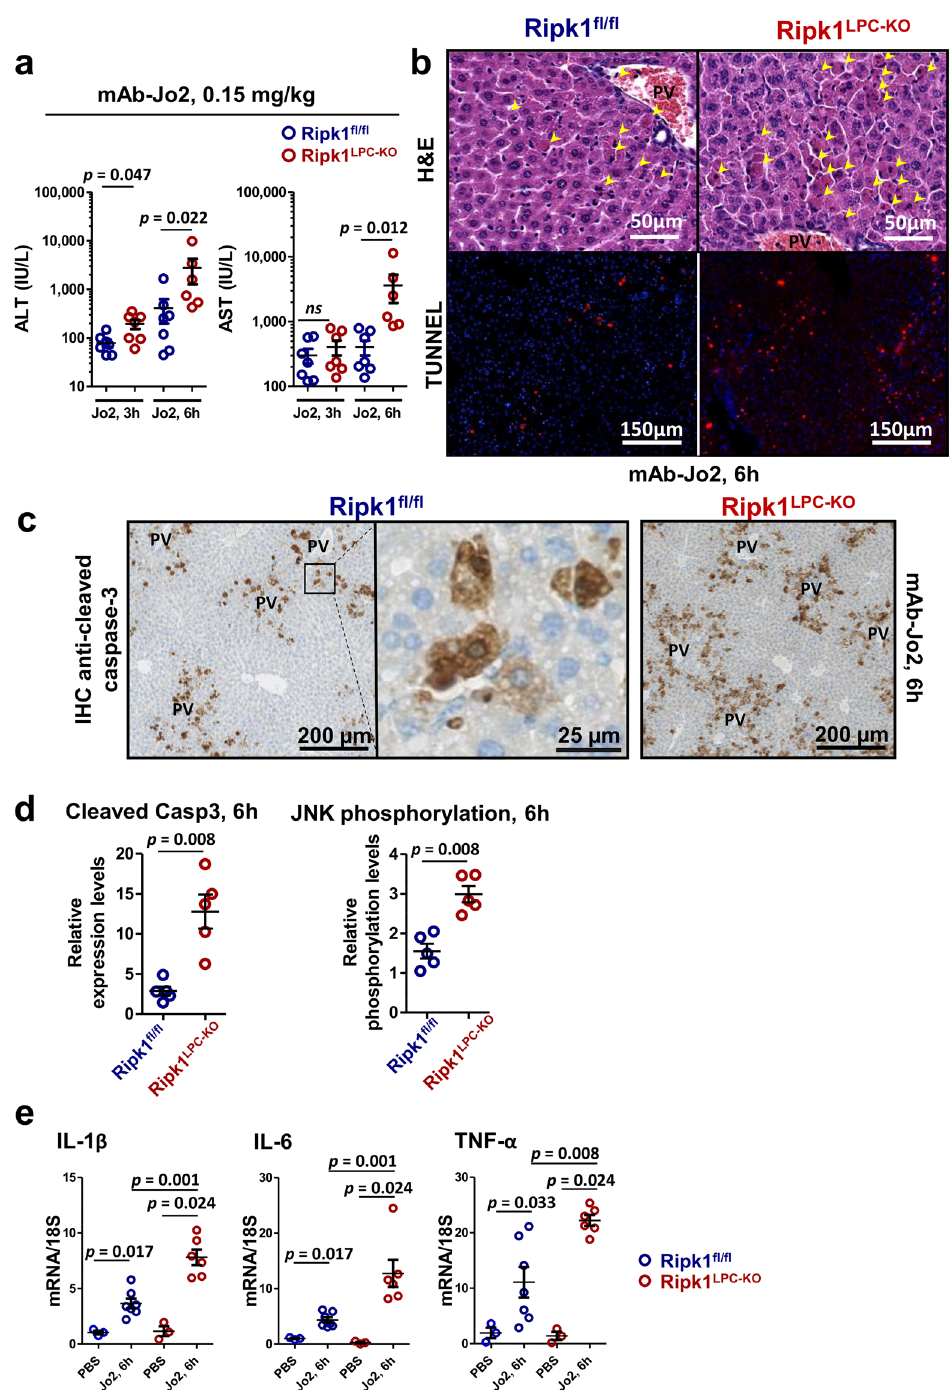
Figure 2. RIPK1 deficiency sensitizes mice to Fas-mediated liver injuries. ( a ) Levels of serum ALT and AST, 3 and 6 h after mAb-Jo2 injection in Ripk1 fl/fl and Ripk1 LPC-KO mice (n = 6–7). ( b ) Pictures of liver tissue sections, stained by H&E (upper panels) or analysed by TUNEL (in red) and DAPI (in blue) immunofluorescence (lower panels) issued from Ripk1 fl/fl and Ripk1 LPC-KO mice, 6 h after mAb-Jo2 injection. Yellow arrows show necrotic areas, PV: portal vein. ( c ) Immunostaining of cleaved caspase-3 in the livers of Ripk1 fl/fl and Ripk1 LPC-KO mice, 6 h after mAb-Jo2 injection. ( d ) Mean levels of cleaved caspase-3 (left panel) and of JNK phosphorylation status (right panel) in the livers of Ripk1 fl/fl (n = 5) and Ripk1 LPC-KO (n = 5) mice, collected 6 h after mAb-Jo2 injection (see corresponding Western blots in Supplementary Fig. S1). ( e ) Levels of hepatic IL-1 β , IL-6 and TNF- α transcripts in Ripk1 fl/fl or Ripk1 LPC-KO mice, 6 h after PBS (n = 3 mice) or mAb-Jo2 injection (n = 6–7 mice). For all graphs, each circle represents an